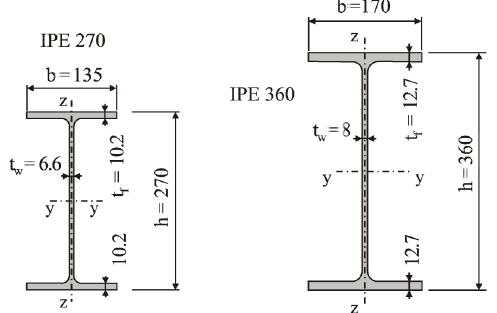
Fig. 4. Nominal geometry of cross-section of